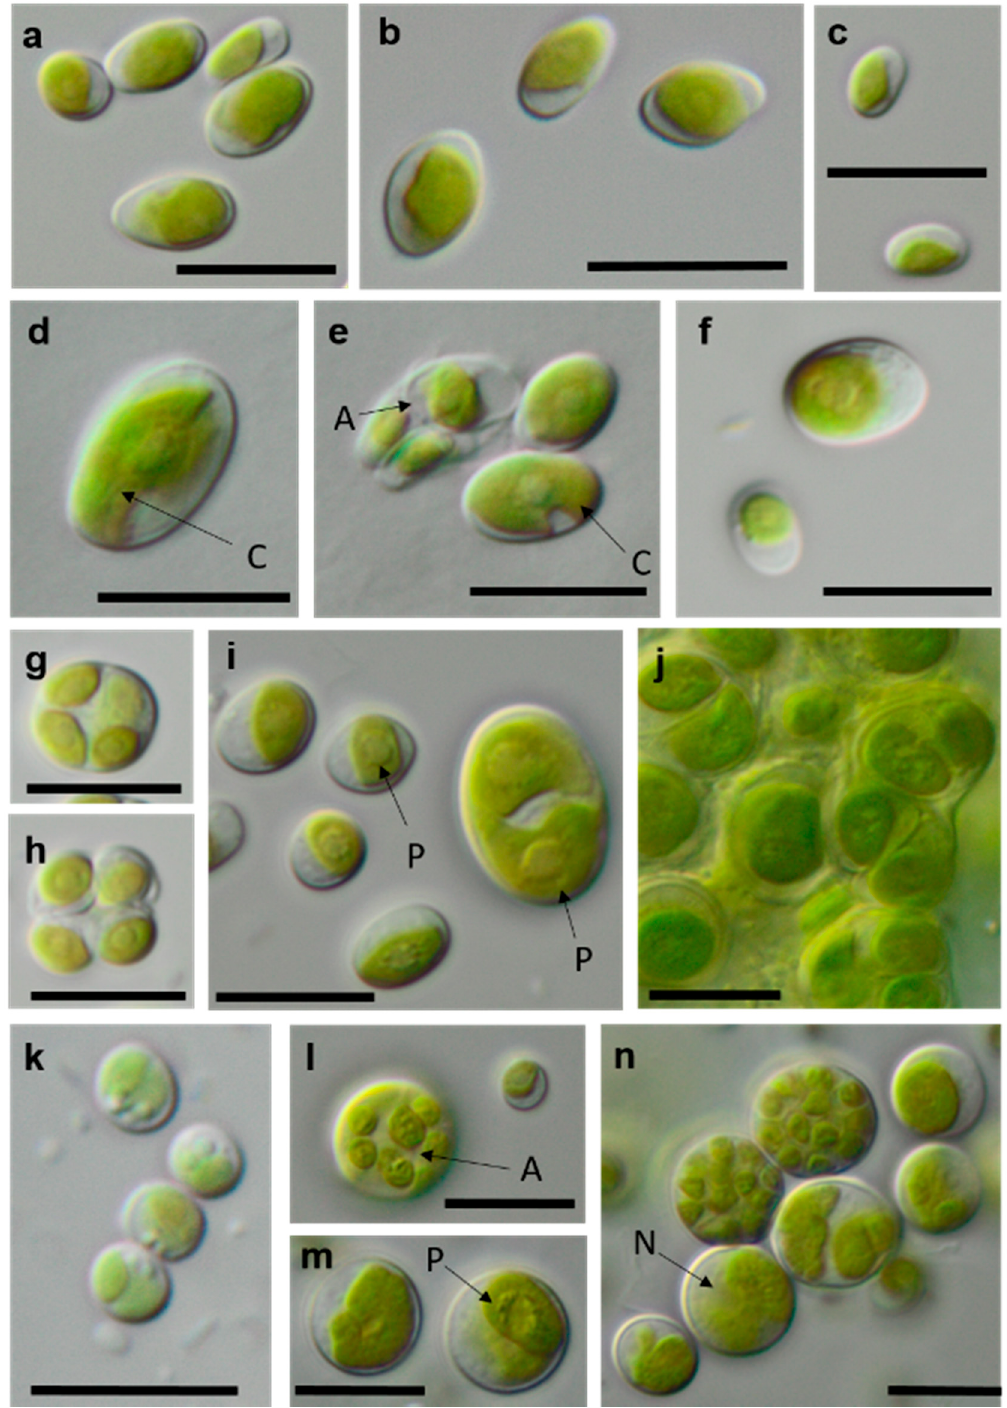
Figure 13. Photomicrographs of Trebouxiophyceae isolates (2). ( a – c ) Chloroidium saccharophilum OD-1-1-C with a smooth chloroplast; ( d , e ) Chloroidium sp. OD-1-1-K with lobed chloroplast ( d ) mature cell, ( e ) autospore, and mature cells; ( f – j ) Pseudochlorella signiensis TSN-1 ( f ) young cells, ( g ) autosporangium, ( h ) autospores, and ( i ) cells with sharp pyrenoids; ( j ) mature cells in cell aggregate; ( k ) Nannochloris sp. TT-3-1-F; and ( l – n ) Watanabea sp. NN-1-1-E ( l ) autosporangium, ( m ) mature cells with parietal chloroplast, and prominent pyrenoid. Arrow labels: A = autospore, N = nucleus, and P = pyrenoid. Scale bars: 10 µm.